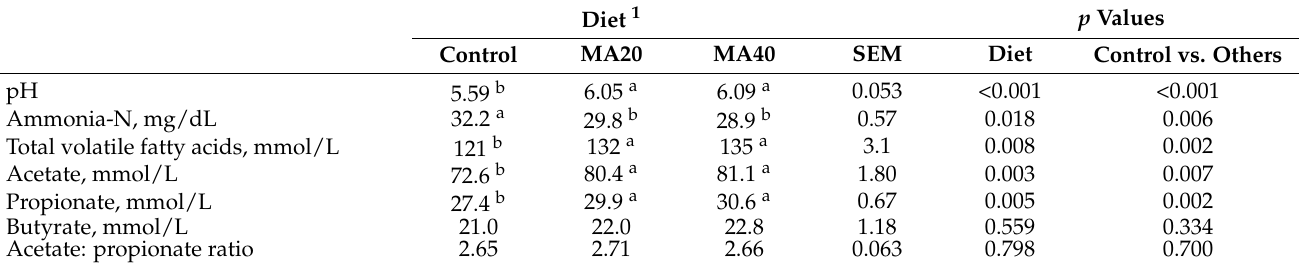
Table 3. Ruminal fermentation parameters of lactating Damascus goats fed diets containing Moringa oleifera and Chlorella vulgaris microalgae ( n = 15). Diet 1